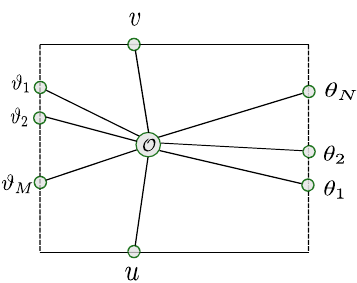
, which is the matrix element v O n,m u (cid:31) | | (cid:29)